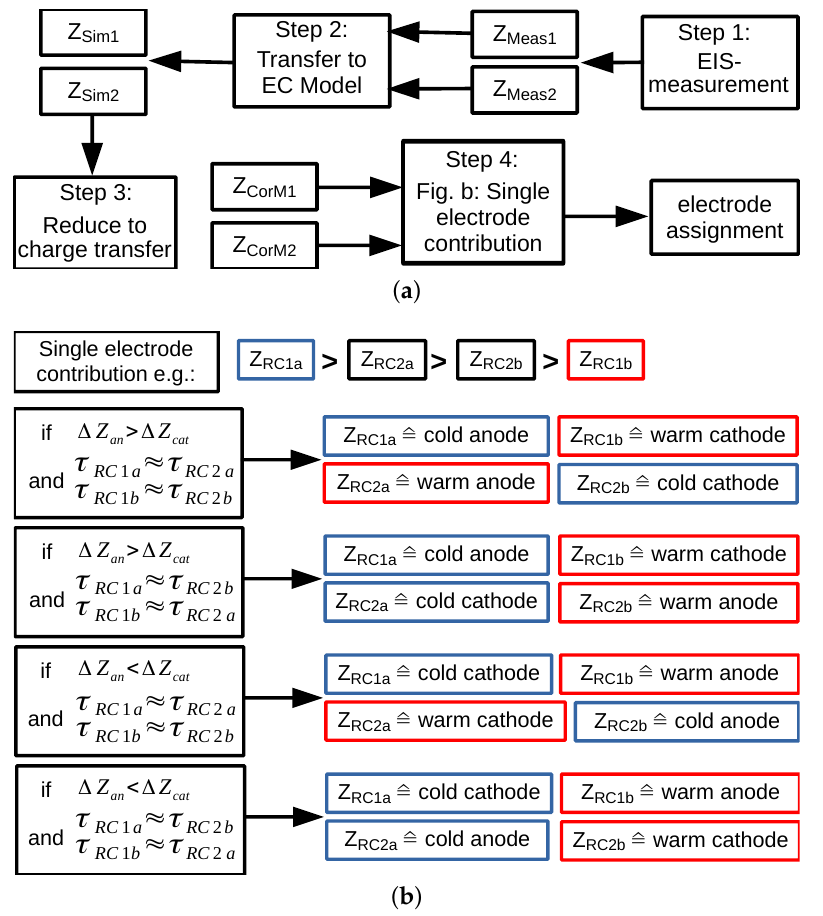
Figure 4. Schematic visualisation of the procedure to assign electrodes: ( a ) Flow diagram from first measurement to electrode assignment. ( b ) Block diagram: Four possible results for the differences of the impedances and the time constants ( left ) and the resulting electrode assignments ( right